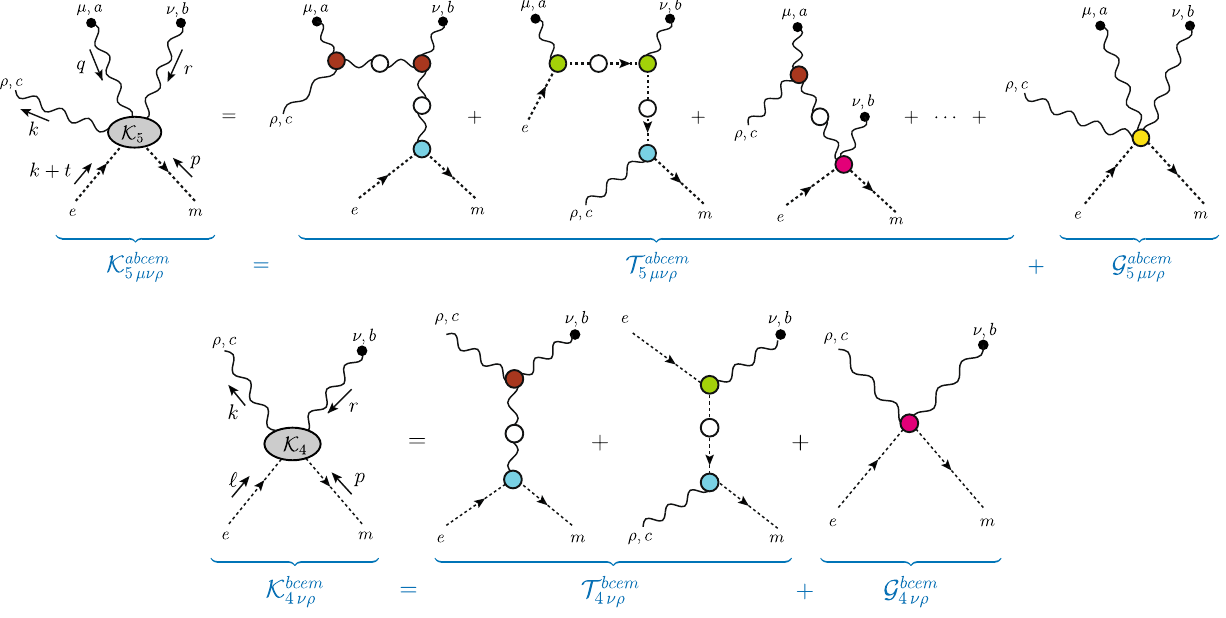
cate additional 1PR graphs not shown. Second row: The corre- sponding contributions of K bcem